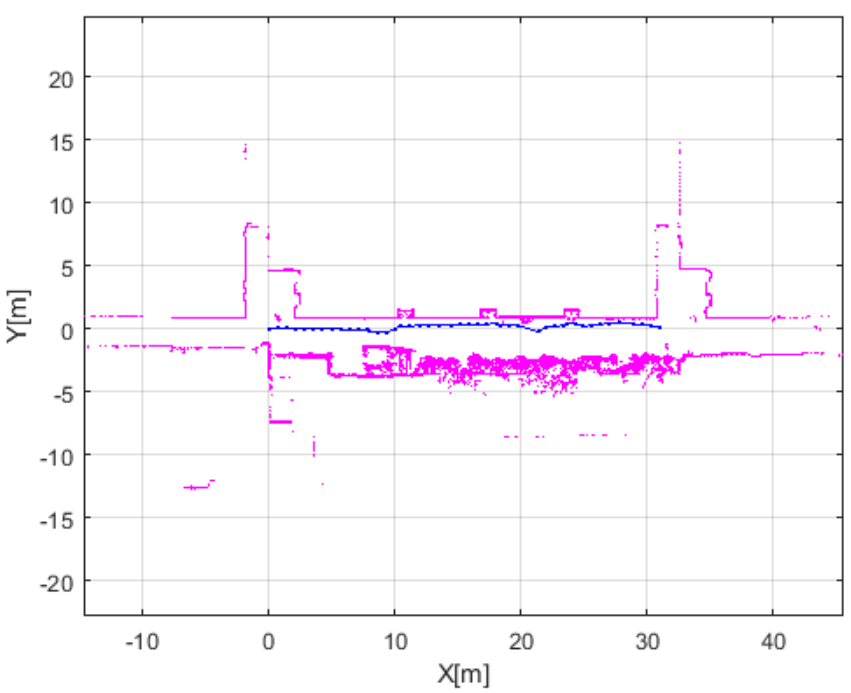
Figure 11. Map created using active SLAM algorithm.